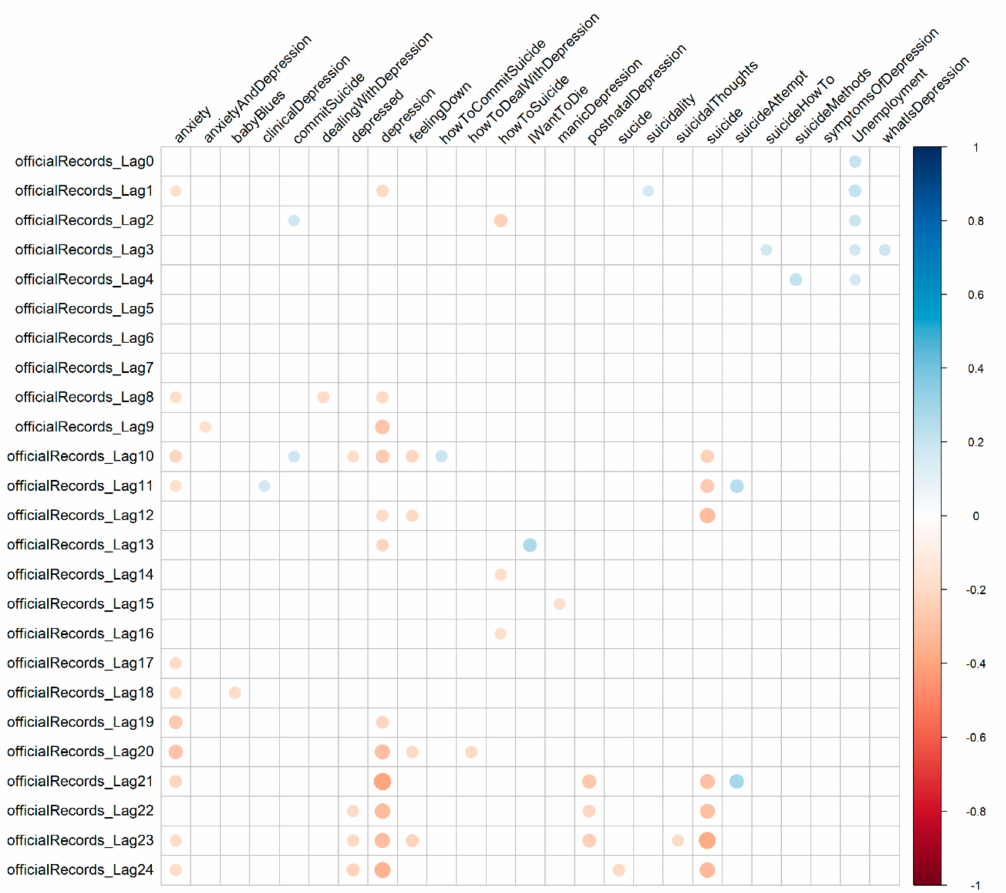
Figure 2. Correlation coe ffi cients for Irish suicide data, Google search queries, and unemployment at di ff erent lags. The correlation coe ffi cient value-color correspondence is represented on the bar on the right. Queries with a correlation not statistically significant are omitted; these include “suicidal”, “how to kill yourself”, “painless suicide”, “suicide forum”, “how to hang yourself”, “signs of depression”, “severe depression”, “post natal